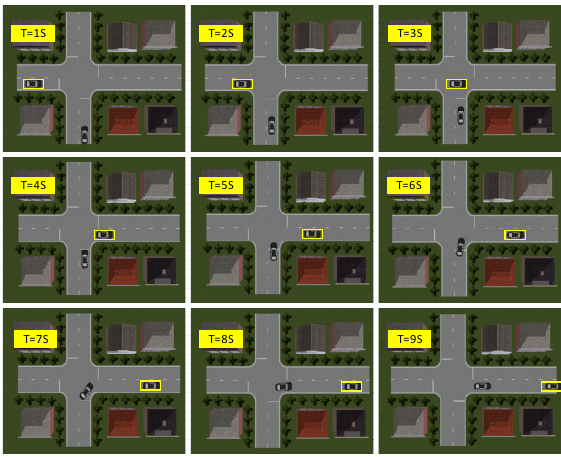
Figure 20. Simulation animation of condition II.